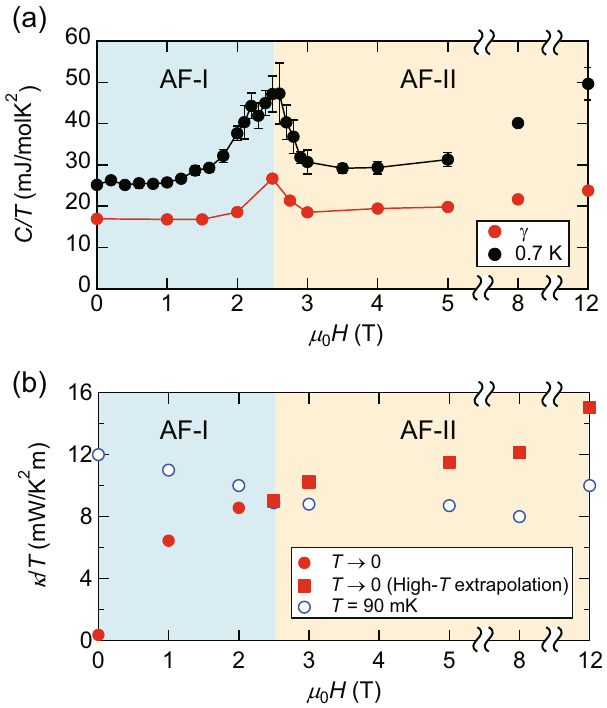
Supplementary Fig. 1. Near the boundary between the AF-I and in the AF-I phase and in high- fi eld regime in the AF-II phase, Δ M is nearly independent of H . In the ordered phase, Δ M is determined by the competition between the Zeeman fi eld and the molecular fi eld due to the magnetic moment around the magnetic ions. When magnetic order is stabilized, the molecular fi eld dominates and Δ fl uenced by the Zeeman M is not seriously in fi eld. Because the magnetic order is suppressed and magnetic fl uctuations are enhanced near the phase boundary, Δ M is suppressed, consistent with the observed behavior of Δ M . Fig. 7 Field dependence of the fermionic excitations. a Field dependence of γ , which is obtained by the fi tting using Eq. (1) (see Fig. 6a – h), and C / T at 0.7 K. The error bars represent standard deviation. b Field dependence of the residual thermal conductivity K 0 ( fi lled red circles) in the AF-I phase and κ / T obtained by the extrapolation from high-temperature regimes to T = 0 in the AF-II phase ( fi lled red squares). Open blue circles represent κ / T at 90